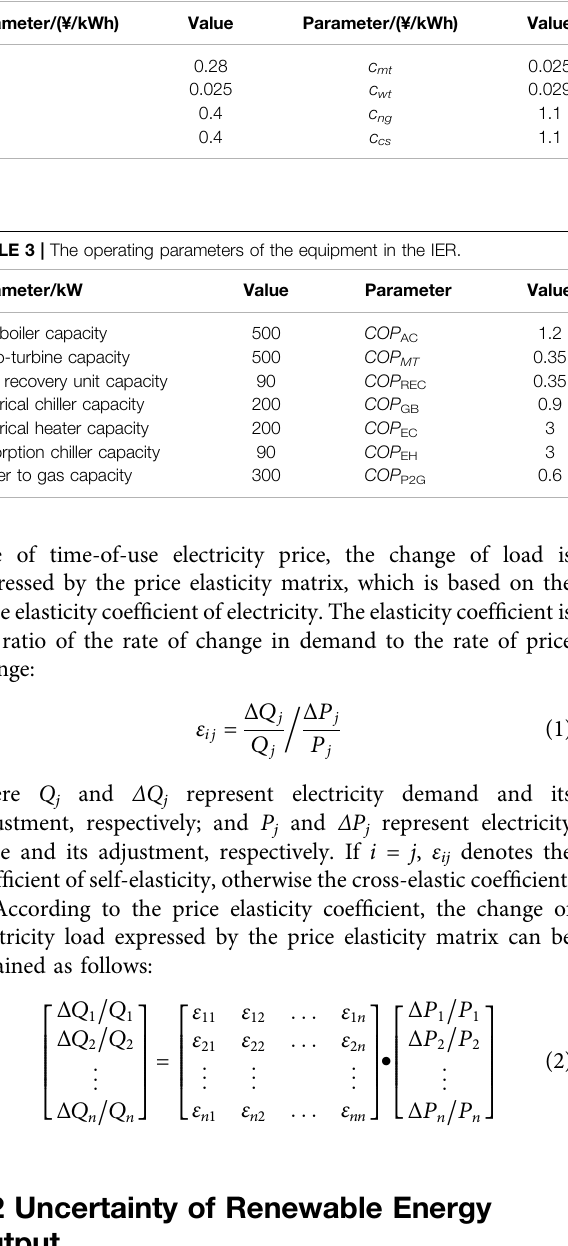
TABLE 1 | Description of the four cases. TABLE 2 | The economic parameters of the IER and power grid.